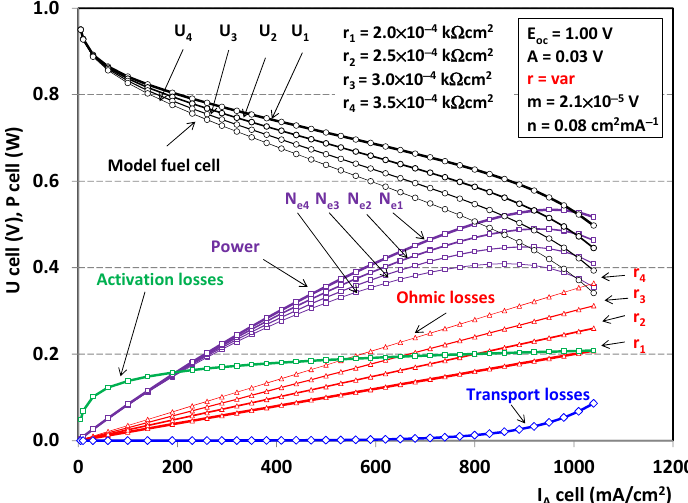
Figure 7. Impact of a changing resistance r on the I–U characteristic and fuel cell power.